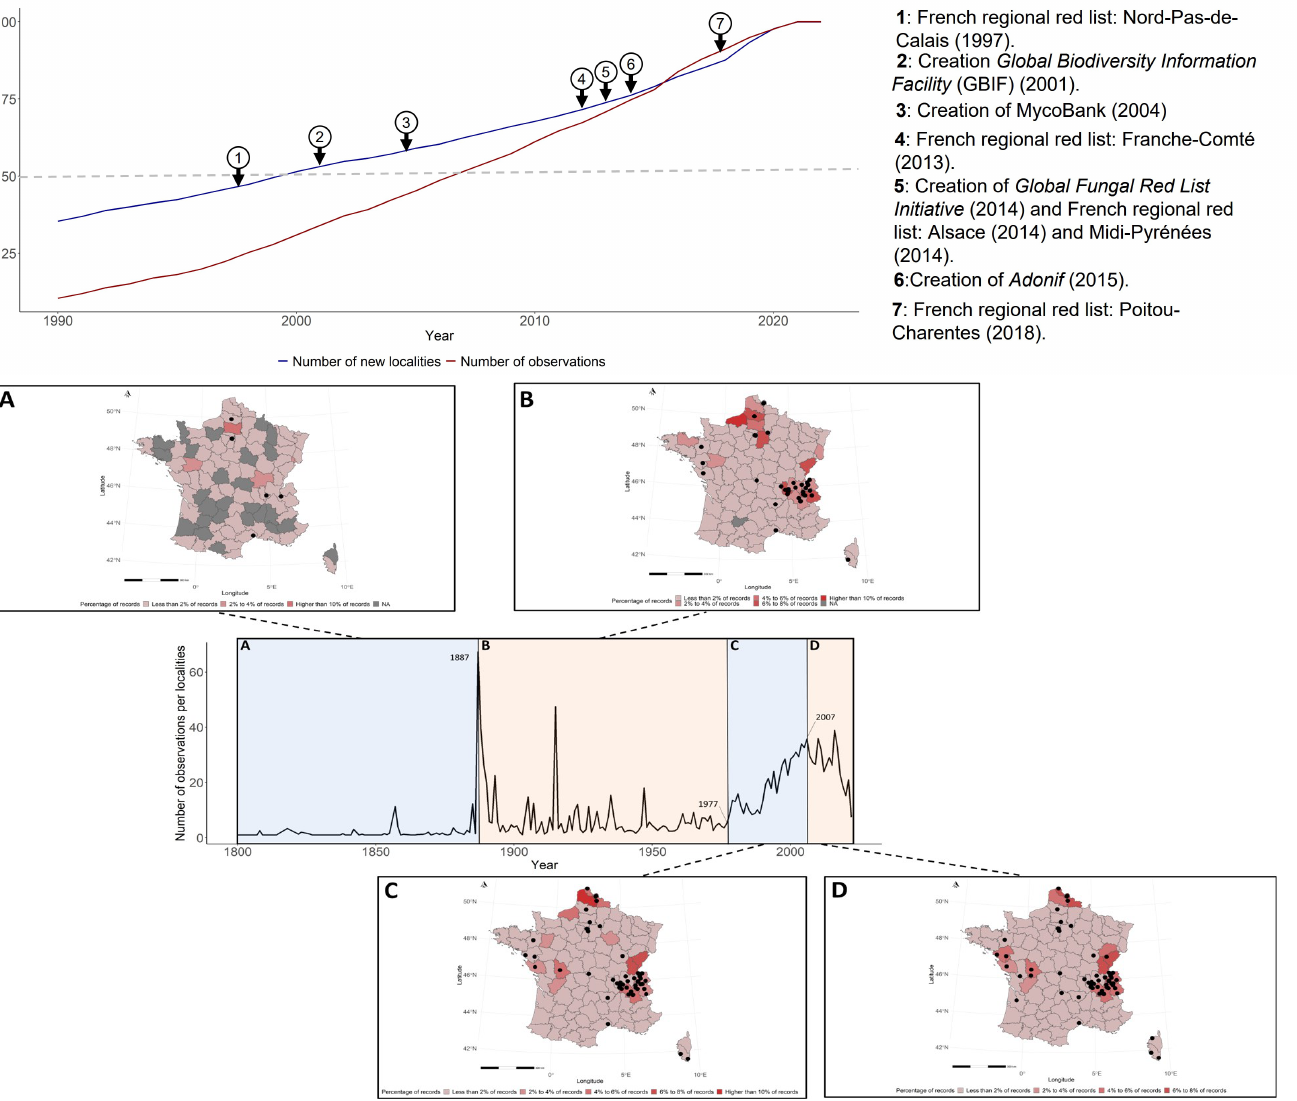
Figure 3. Temporal dynamics of fungal recording in France during the period [1800–2022]. ( A ) Accumulation curve of sampled sites and records during the whole period, expressed in percent. ( B ) Detailed representation of the period [1990–2022], with the position of main fungal conservation initiatives at global and national scales. ( C ) Temporal dynamics of recording per site during the whole period, with corresponding map of the distribution of fungal records across administrative units in France. Shaded areas represent the four steps of data acquisition dynamics, based on graphic analysis. Black dots indicate the location of mycological